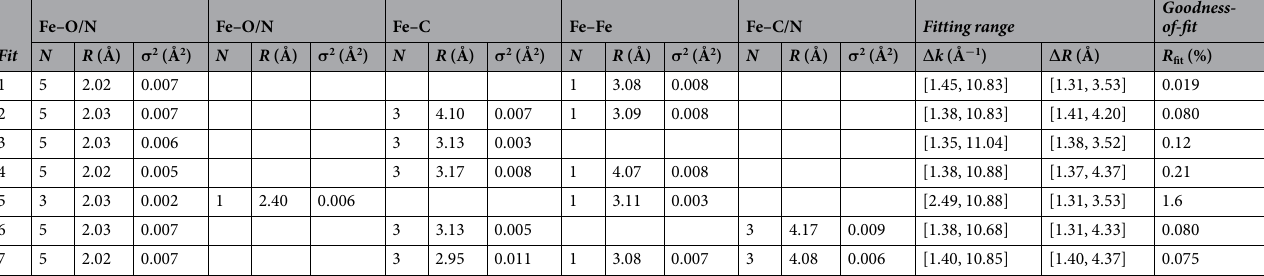
Table 2. Fitting of the k 3 -weighted EXAFS data for alkane hydroxylase (AlkB). (a) Results of fits 1–7 to EXAFS data for AlkB. Errors are estimated to be 25% for coordination numbers and 0.01–0.03 Å for distances 38 . Parameters used in the fitting include: N , the coordination number; R (Å), the distance relative to Fe; σ 2 (Å 2 ), the Debye-Waller factor; and R fit (%), the goodness-of-fit parameter. (b) Fitting range for each fit. Ranges for k space (Å − 1 ) and R space (Å) are indicated by Δ k and Δ R , respectively.